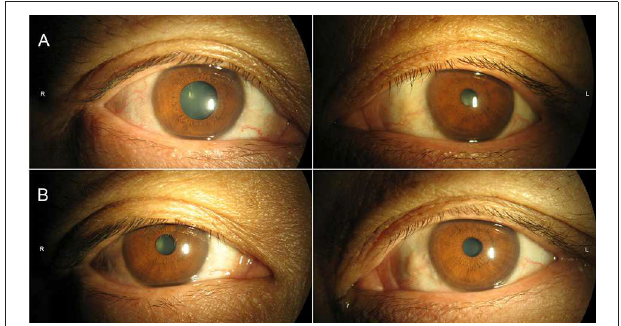
FIGURE 1 | Pupils were mid-position in ambient light (A) without constriction in response to bright light. (B) Thirty minutes following diluted (0.0625%) pilocarpine solution, pupillary constriction of right eye was noted.